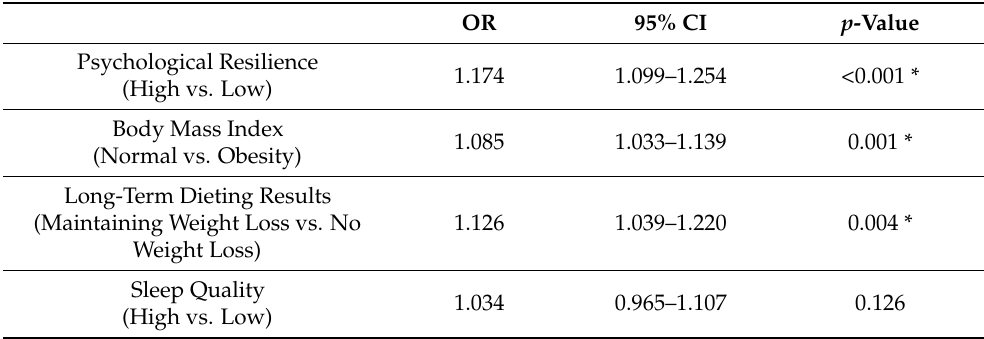
Table 3. Multinomial logistic regression analysis between NAFFAME and PsyR, BMI, long-term diet results, and sleep